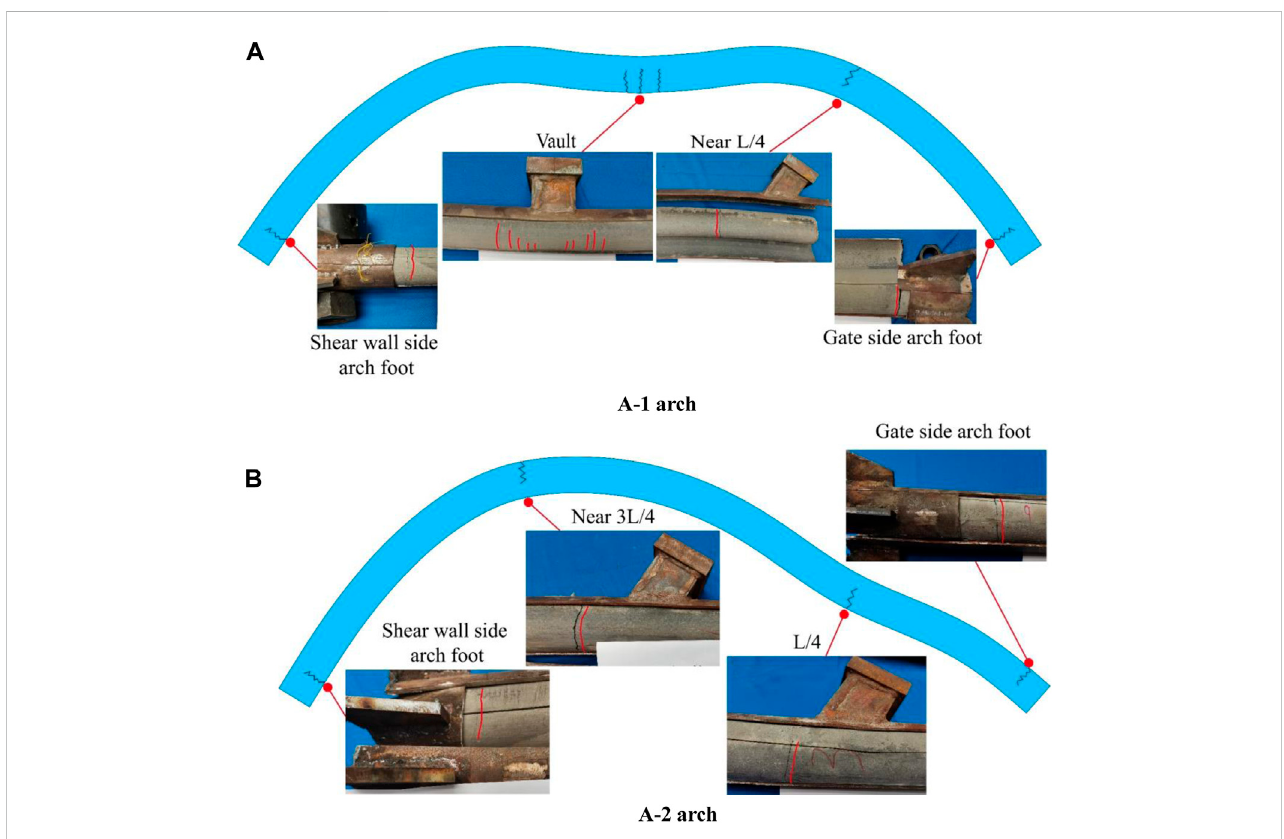
FIGURE 13 Failure state of concrete in the pipe after failure: (A) A-1 arch; (B) A-2